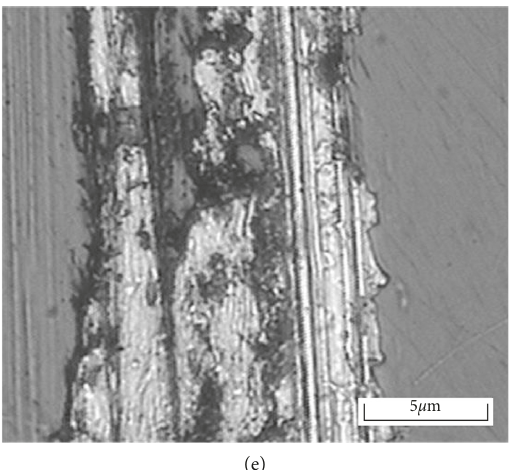
Figure 7: Morphology of TiSiN/AlN nanomultilayers. (a) Thickness of the AlN layer is 1 nm. (b) Thickness of the AlN layer is 1.5 nm. (c) Thickness of the AlN layer is 2nm. (d) Thickness of the AlN layer is 2.5nm. (e) Thickness of the AlN layer is 3